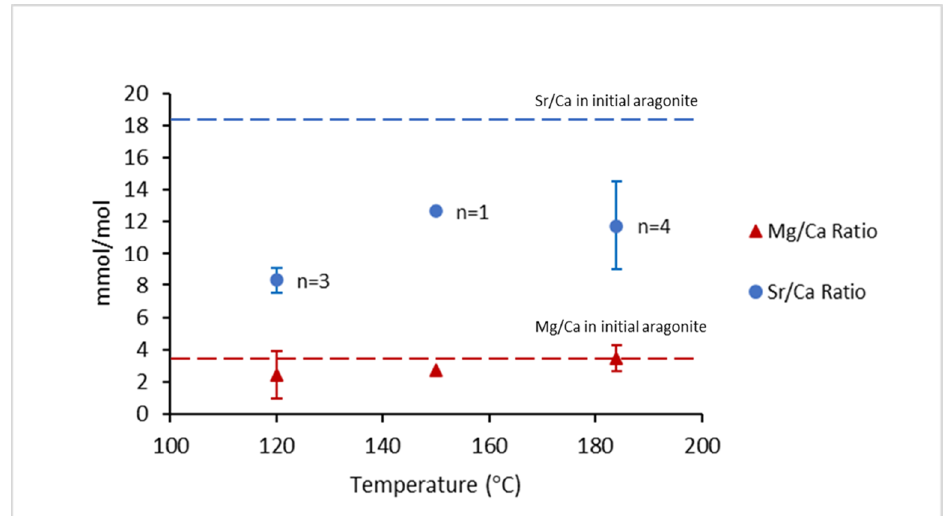
Figure 8. Average ratios of Sr/Ca and Mg/Ca of the multiple ( n ) experiments where calcite was placed at the bottom of the autoclaves. Red triangles represent the Mg/Ca ratio and blue circles represent the Mg/Ca ratio. The red and blue dashed lines represent the Sr/Ca and Mg/Ca ratios of the initial aragonite, respectively.